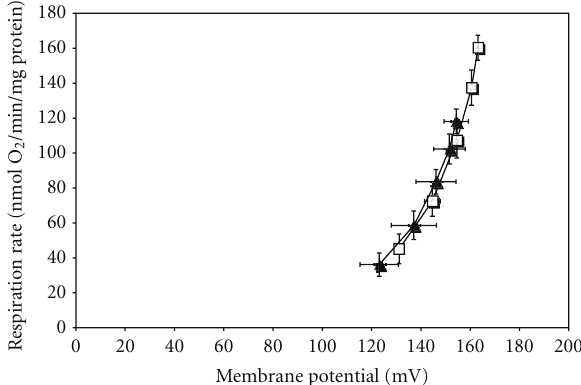
Figure 7: Proton leak of mitochondria from kidney showing controls and low protein fed rats. Empty box (cid:2) : control; filled triangle (cid:3) : low-protein. The highest common potential was 154mV. Duplicate measurements were performed on each preparation and averaged. Values are means ± S.E.M. from 5 independent preparations for each